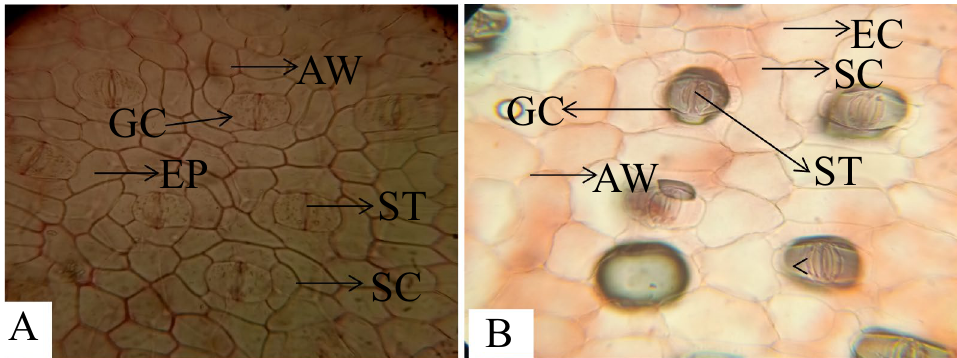
Fig. 3 Surface view of Abaxial epidermis (X400). A Costus afer B Palisota hirsuta . AW: Anticlinal wall; EP: Epidermal cell; GC: Guard cell; SC: subsidiary cell; ST: stomata. Abaxial epidermis also referred to as lower layer was gotten by scraping the abaxial epidermis (upper layer) of the leaf of each plant, cleared in 2% v/v Sodium hypochlorite and rinsed severally in distilled water. The cleared epidermal tissues were stained with Safranin O and then dehydrated in vials containing 50%, 70% and 100% ethanol successively. This was mounted on microslide with dilute glycerol and